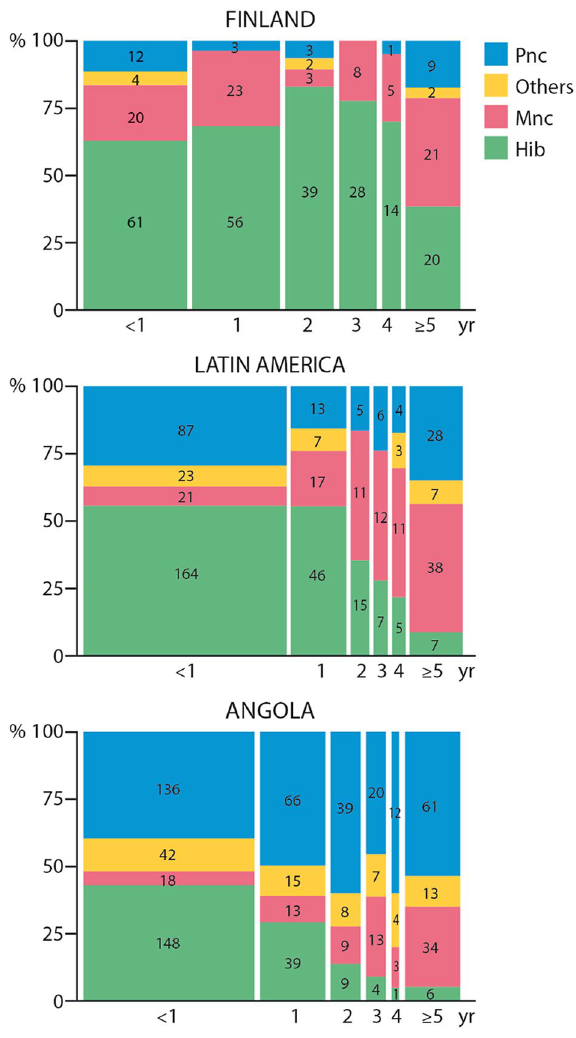
Figure 1. The etiology as a function of age in Finland, Latin America, and Angola. Pnc Streptococcus pneumoniae; Others denotes mainly Gram-negative rods; Mnc Neisseria meningitides , Hib Haemophilus influenzae type